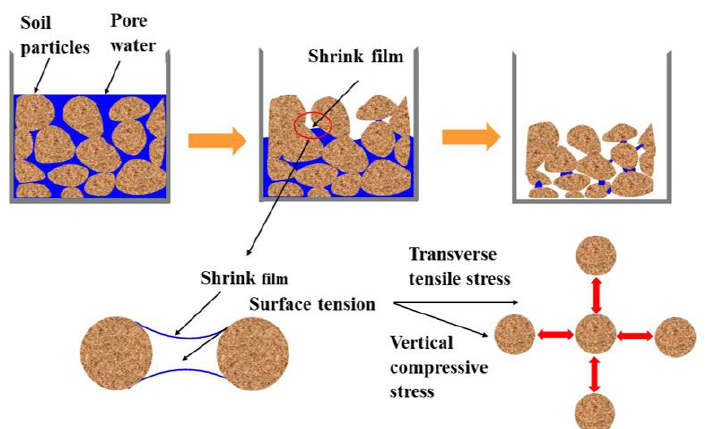
Figure 5. Schematic description of mechanism leading to formation of desiccation cracking of plain soil-cement [32].